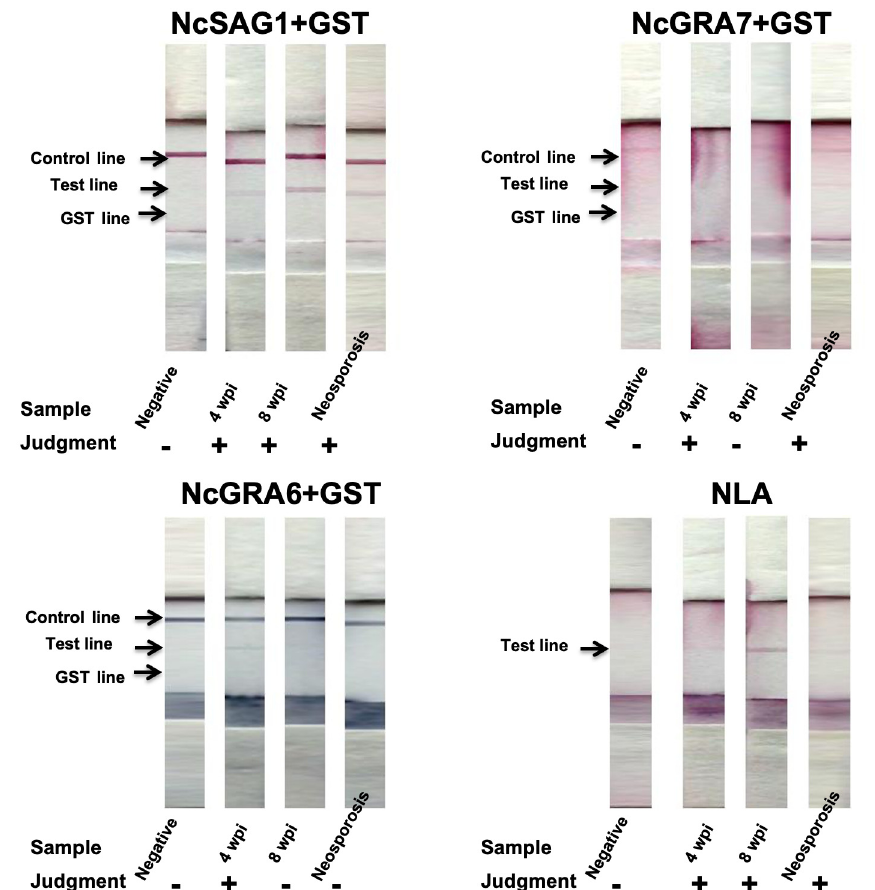
Figure 4. Immunochromatographic test (ICT) assay results against experimental and control cattle sera. A representative strip for each group of samples is illustrated for tested antigens. Negative, non-infected cattle sera ( n = 6); 4 wpi, cattle serum samples from experimentally infected calves at 4 weeks post-infection ( n = 4); 8 wpi, cattle serum samples from experimentally infected calves at 8 weeks post-infection ( n = 5); neosporosis, sera from N. caninum -naturally infected heifers experienced abortion and confirmed by immunohistochemistry ( n = 8). “ − ” or ”+” on graph indicates no or appearance of test band reactivity of the strip.